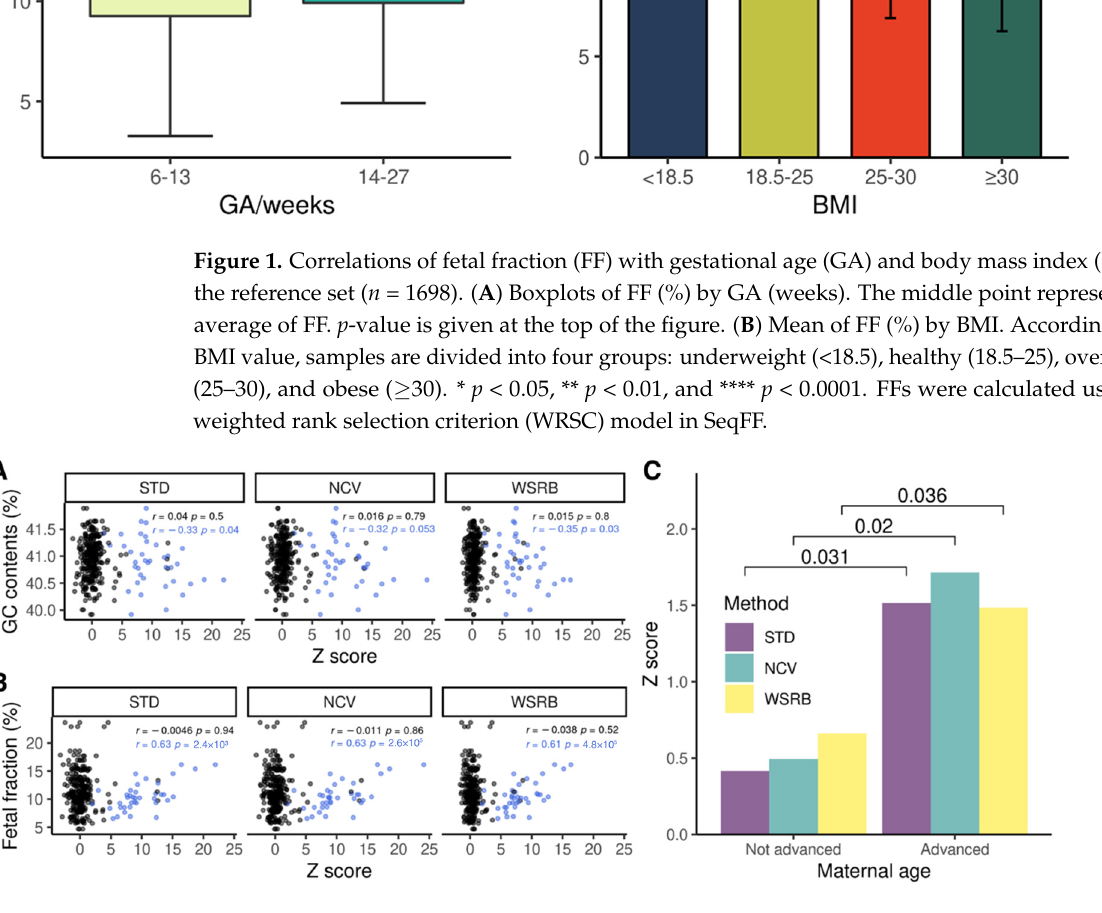
Figure 2. Correlations of Z-scores obtained using three methods (STD, normalized chromosome value [NCV], and WSRB) with GC content (GC, %), FF (%), and maternal age in 109 non-invasive prenatal testing (NIPT) samples. ( A ) Relationship between GC content (%) and Z-score. ( B ) Relationship between FF (%) and Z-score. A dot point represents a Z-score of a specific chromosome (chr 13, 18 or 21) from a sample. Therefore, each graph has 327 points displayed. Black represents a normal sample, and blue represents a trisomy sample identified by chorionic villus sampling (CVS) or amniocentesis. In each graph, p -value and r-value were calculated for normal and trisomy group, respectively. ( C ) Mean of Z-scores of three methods (STD, NCV, and WSRB) by maternal age. Advanced maternal age is equal to and older than 35.